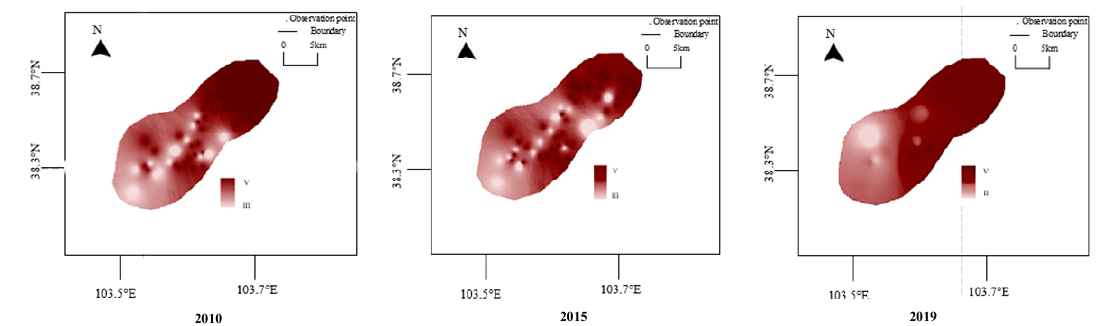
Figure 9. Spatial distribution of groundwater quality in the research area of the three representative years.